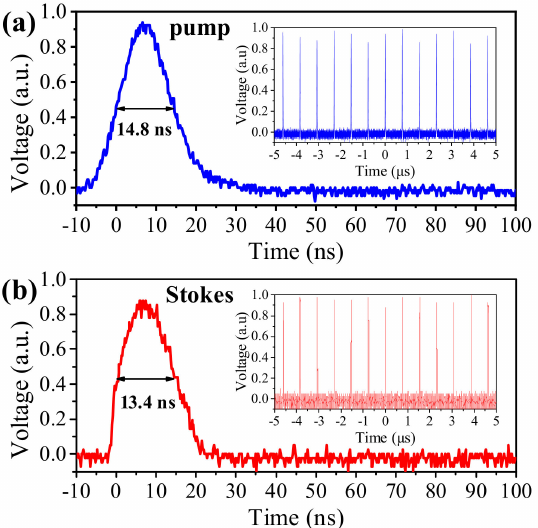
Figure 3. Measured temporal characteristics of ( a ) pump pulses and ( b ) Stokes pulses when the pump power is maximum and repetition frequency is 1.3